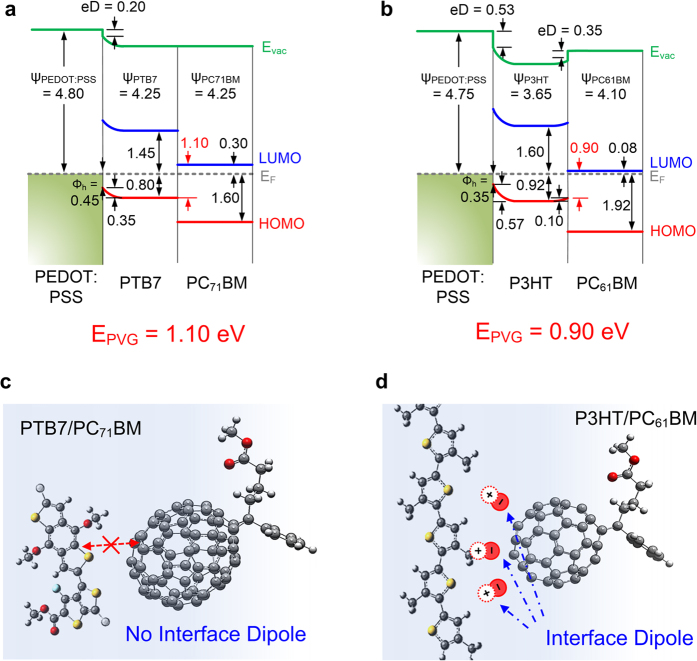
Energy level diagrams.Energy level diagrams of (a) ITO/PEDOT:PSS/PTB7/PC71BM and (b) ITO/PEDOT:PSS/P3HT/PC61BM. Фh and eD are the hole extraction barrier and interface dipole, respectively. ΨITO, ΨPEDOT:PSS, ΨPTB7, ΨPC71BM, ΨP3HT and ΨPC61BM are the work functions of ITO, PEDOT:PSS, PTB7, PC71BM, P3HT and PC61BM, respectively. Comparing the diagrams, we observed the strong interface dipole between P3HT and PC61BM. Schematic image of (c) PC71BM and PTB7 and (d) PC61BM and P3HT interfaces.